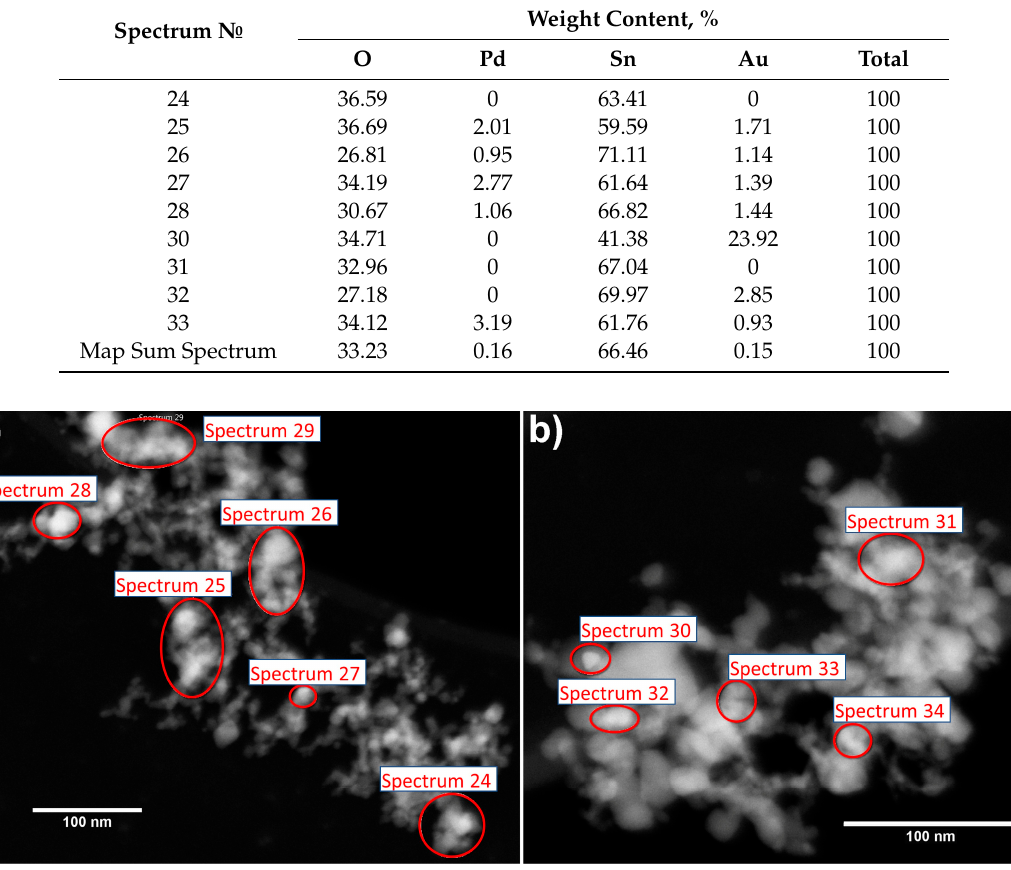
Figure 2. High angle annular dark field scanning transmission electron microscopy (HAADF-STEM) images of different parts of AuPd/SnO 2 sample, ( a ) and ( b ), used during EDX mapping procedure. The obtained EDX maps are not informative due to low Au and Pd content and homogeneous distribution of elements. Local spots, for which spectra were reconstructed from total map spectrum, are designated. Analysis of Au and Pd content at local spots of EDX maps (Table 2) allows conclusions to be made on Pd and Au distribution over the nanocomposite structure.